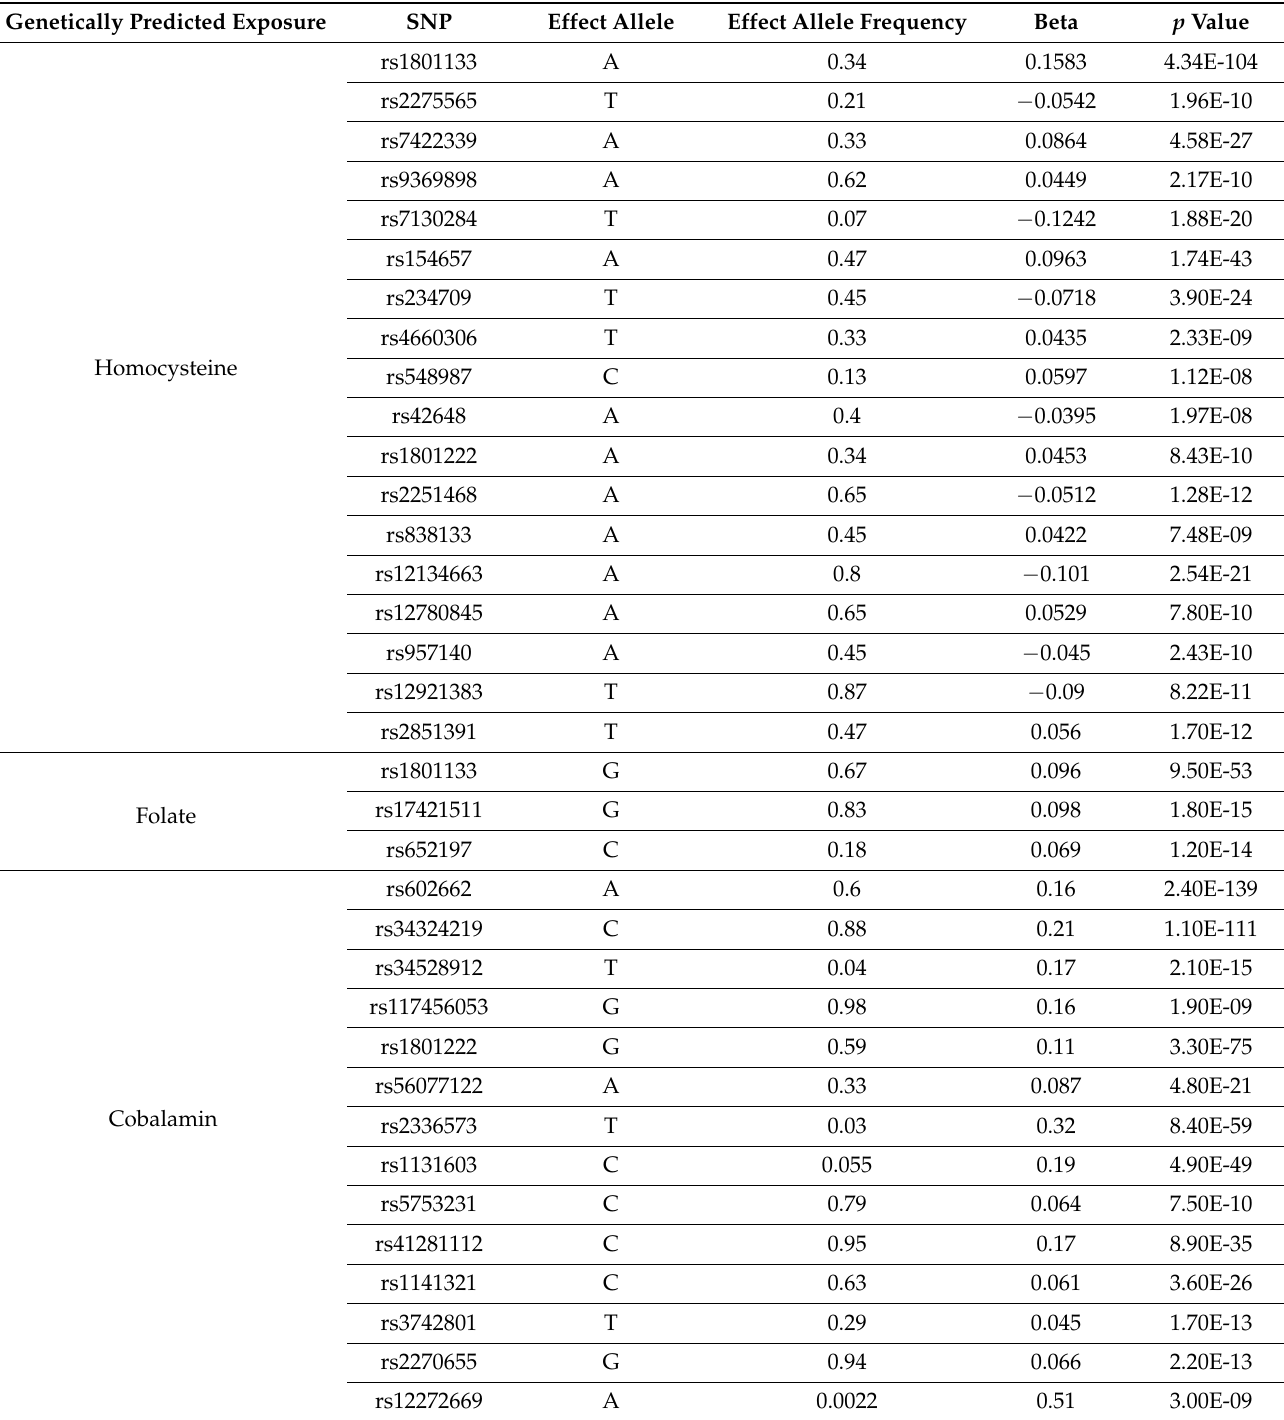
Table 1. The summary statistics of the genetic instrument for blood total homocysteine (N of SNPs = 18), folate (N of SNPs = 3), and cobalamin levels (N of SNPs =